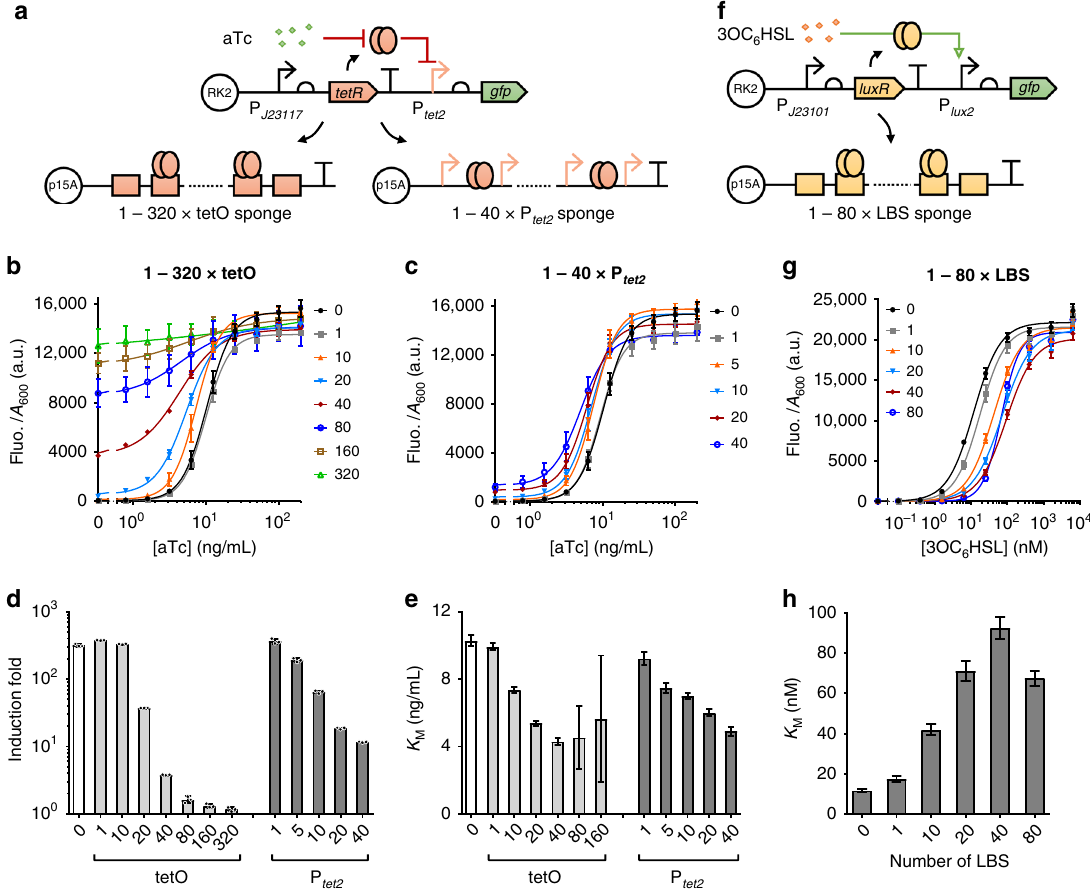
Fig. 2 Synthetic DNA sponge enables tuning output gene expression by decoying receptors within circuits ’ input sensing modules. a Schematic showing the design of two types of synthetic DNA sponges to decoy TetR in an aTc-responsive circuit: 1 – 320 repeats of TetR operator (tetO) or 1 – 40 repeats of P tet2 promoter. b , c The aTc responsive circuit ’ s dose-responses with sponges containing different numbers of the tetO ( b ) or the P tet2 repeats ( c ). d Induction fold between uninduced and 200 ng/mL aTc induced samples of the circuit with or without the tetO/P tet2 -based sponge regulation as characterized in ( b , c ). e Hill constant ( K M ) of the circuit ’ s fi tted dose-responses from ( b , c ) against different repeat numbers of the tetO/P tet2 -containing sponge. K M value of sample with sponge containing 320 tetO repeats is not shown due to insuf fi cient dose-response of the circuit. f Design of an AHL- responsive circuit with regulation by sponges containing 1 – 80 repeats of the LuxR binding site (LBS). g Dose-responses of the AHL-responsive circuit with sponges containing different numbers of LBS repeats. h Hill constant ( K M ) of the circuit ’ s fi tted dose-responses from ( g ) against different repeat numbers of the LBS-containing sponge. For ( b – d , g ), values are mean ± s.d. ( n = 3 biologically independent samples). For ( e , h ), values are mean ± s.e.m. ( n = 3 biologically independent samples). Fluo., fl uorescence. a.u., arbitrary units. Source data are provided as a Source Data fi